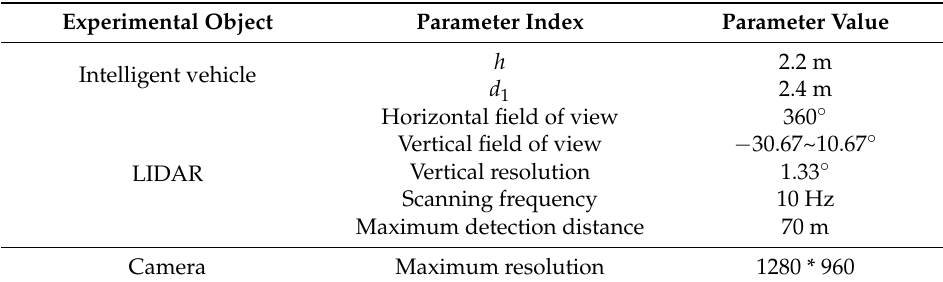
Table 1. Parameters of experimental platform and environment.